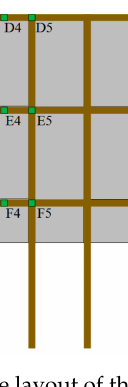
Figure 14. The layout of the strain gauges installed on the crown beam and the waist